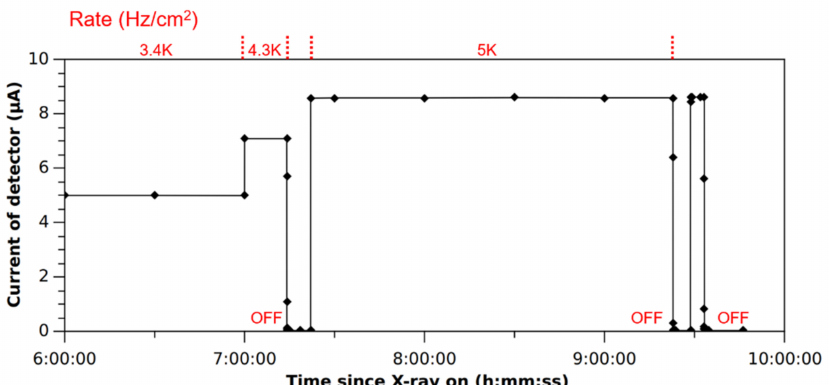
Figure 9. The current of the high-rate sealed prototype under full-area X-ray irradiation. The current at the early 6 h remains unchanged as well.